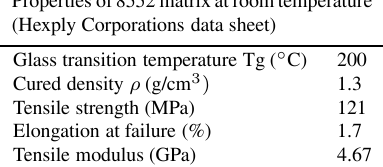
Table 1 Properties of8552 matrixat